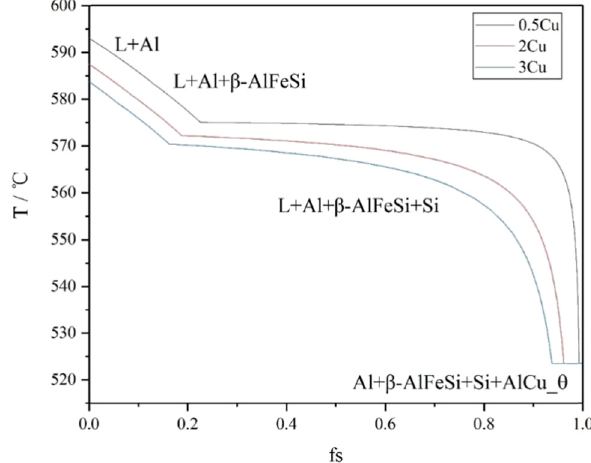
Figure 11: Vertical section phase diagram of Al10Si0.4Fe - Cu system ( FCC is Al, Diamond is Si, Beta_AlFeSi is Al Al 2 Cu ) .